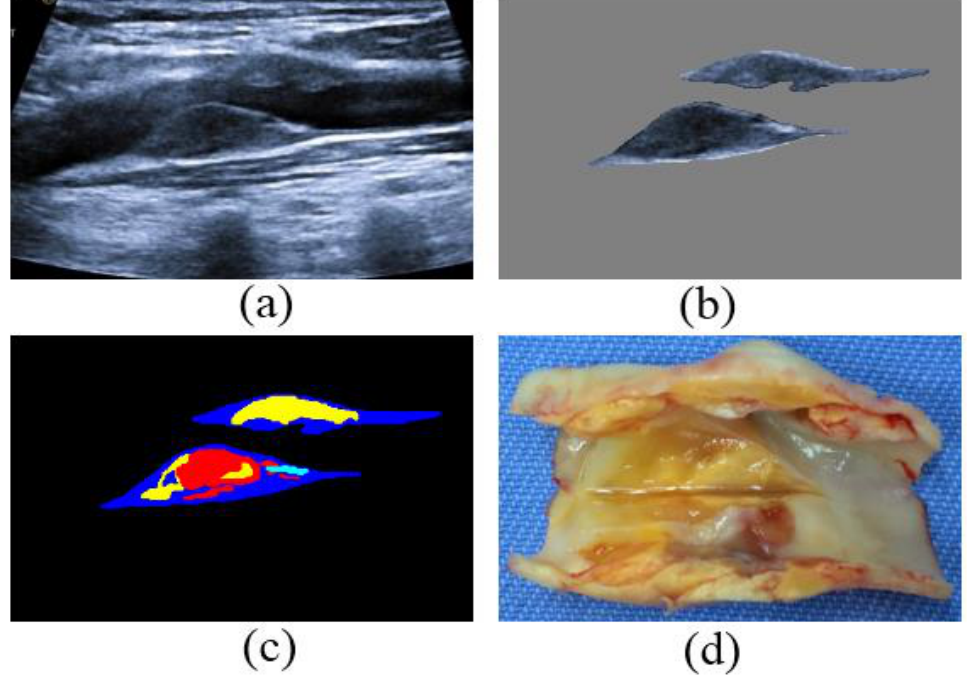
Figure 1. Carotid vulnerable plaques from a patient: ( a ) 2D ultrasound images before endarterec- tomy, ( b ) the solo ultrasound plaques, ( c ) the labels (blue, light blue, yellow, and red denote fiber, calcification, lipid, and hemorrhage components in the plaques, respectively) of ultrasound plaque components in ( b ), and ( d ) the plaques specimen after endarterectomy of the patient.